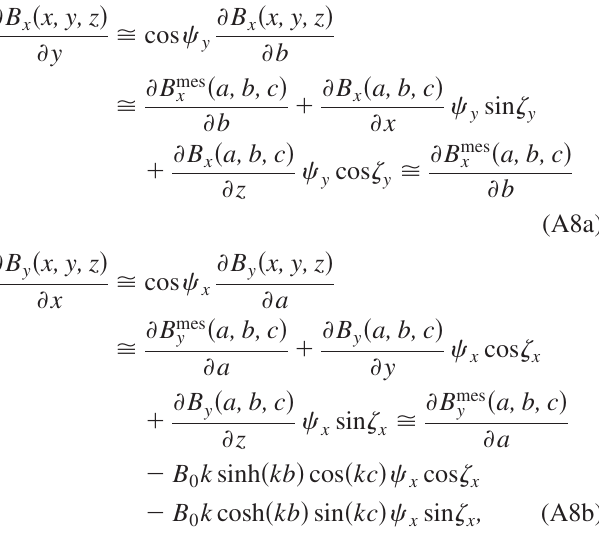
FIG. 17. Horizontal field gradients ( @B lated along the wiggler axis z with no orientation error (solid lines) and with an orientation error ð (cid:7) (cid:2) (cid:5)= 2 Þ of the Hall probe (dashed